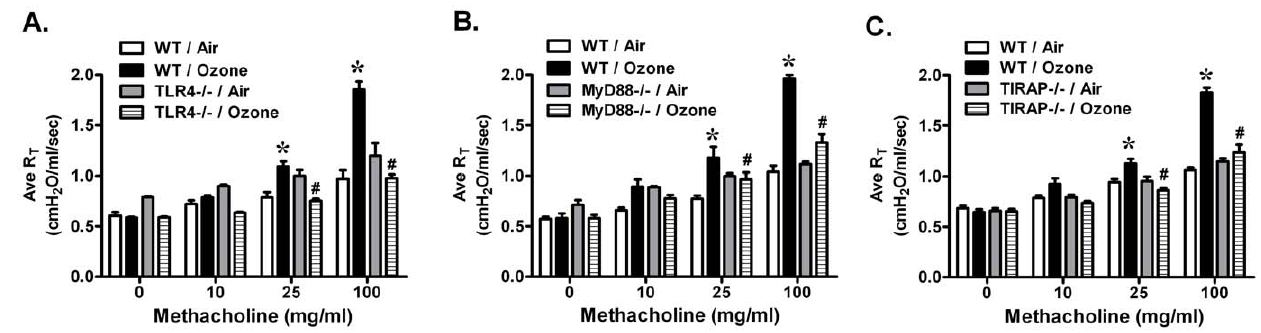
Figure 1. Ozone inhalation increased airway sensitivity to methacholine challenge and was dependent on the TLR4-MyD88-TIRAP signaling pathway. Animals were exposed to filtered air (FA) or 1 ppm of ozone for 3 hours. Airway responsiveness to methacholine challenge was measured 24 h later. A ) Ozone-induced AHR was increased in WT mice but not in TLR4 2 / 2 mice, B ) MyD88 2 / 2 mice, or C ) TIRAP 2 / 2 mice (*p , 0.05 vs. FA-WT; # p , 0.05 vs. O3-WT, N=5–6 per